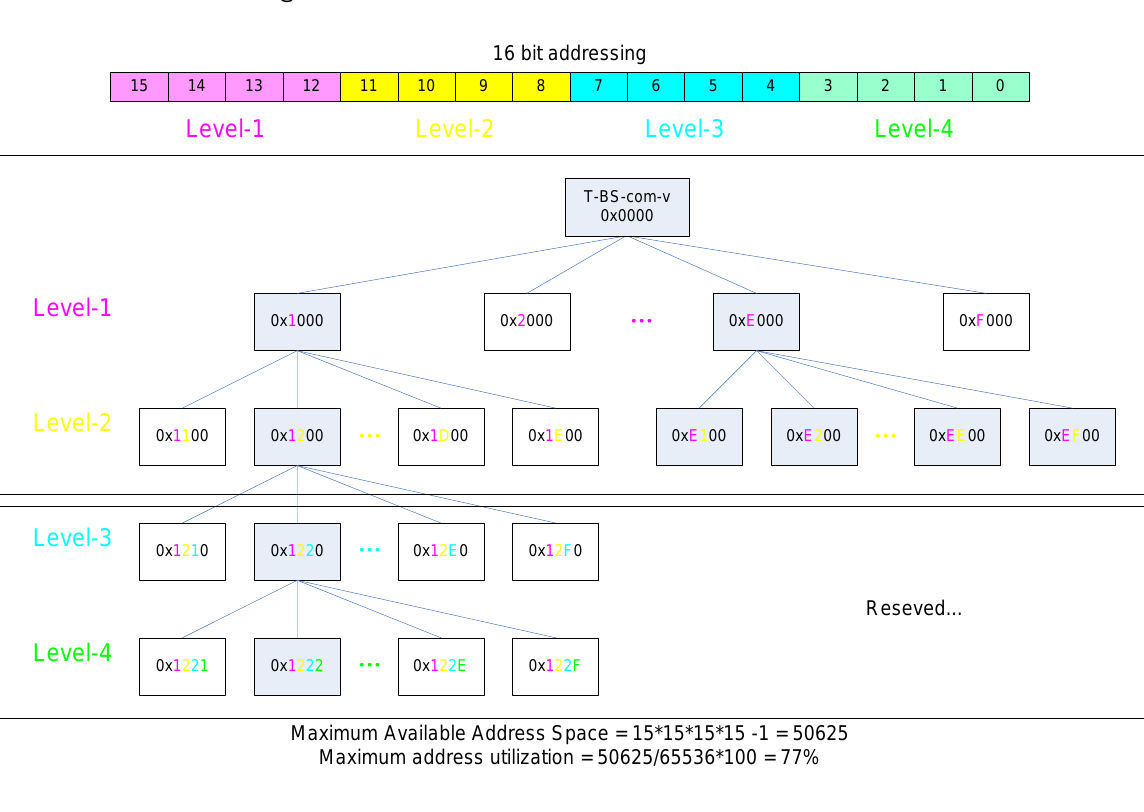
Figure 3. Baseline Tracking Detection Algorithm block